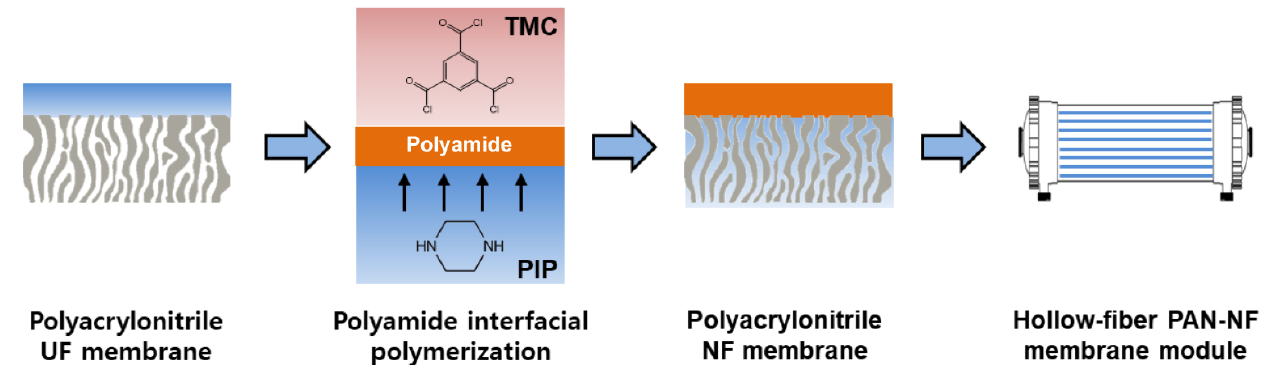
Figure 1. Preparation of the hollow-fiber (HF) polyacrylionitrile (PAN) nanofiltration (NF) membrane.